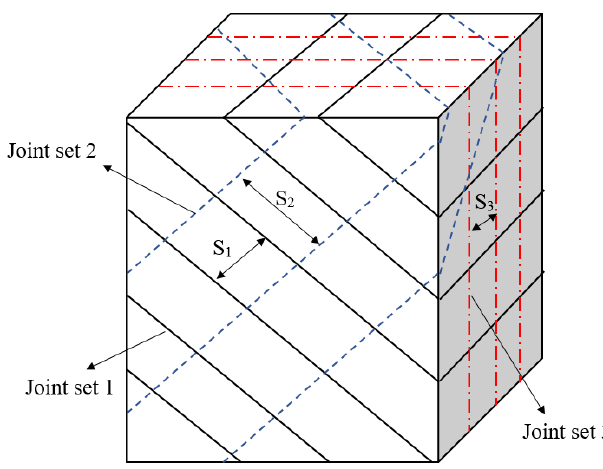
Figure 2. Jointed rock mass containing three random joint sets.